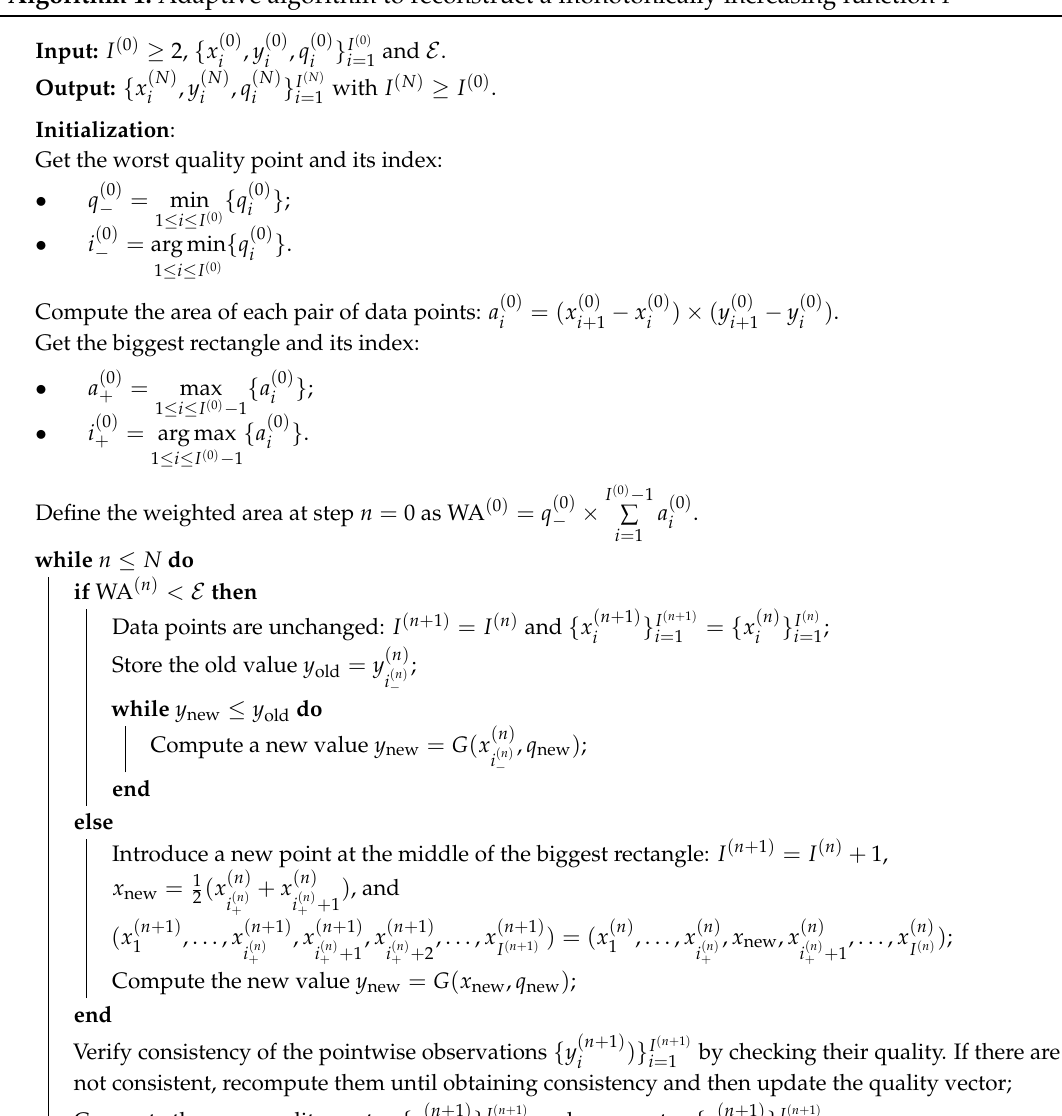
Algorithm 1: Adaptive algorithm to reconstruct a monotonically increasing function F